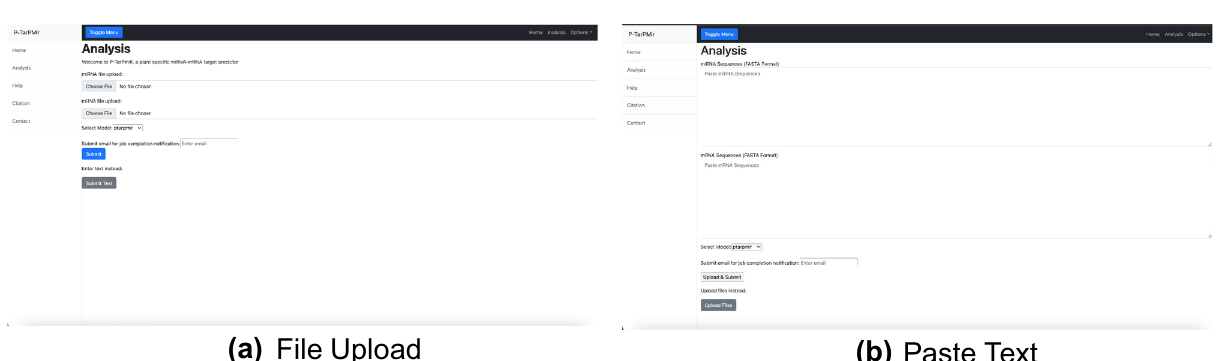
Figure 4. Screenshots of the P-TarPmiR web server job submission page, ( a ) for file upload and ( b ) for direct text input of sequences. Both types of submissions include the ability to add an email so the web server can notify the user when the job is complete. This functionality is particularly useful for large